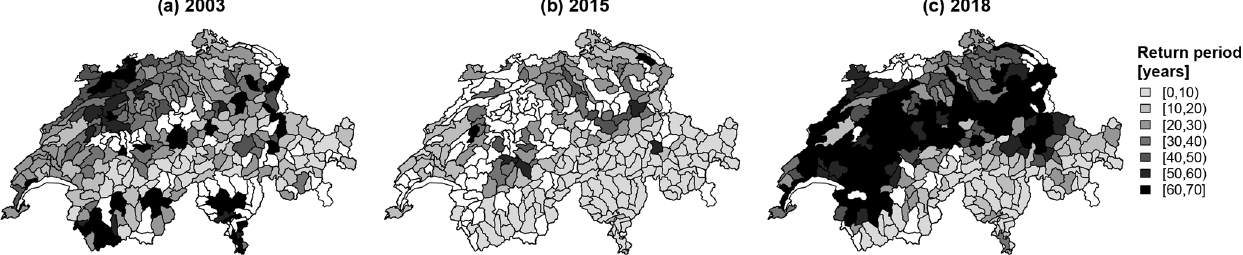
Figure 9. Estimated bivariate AND return periods in terms of discharge deficit and soil moisture deficits for the events in (a) 2003, (b) 2015, and (c) 2018 for the 307 catchments in the simulated dataset. For catchments displayed in white, no joint event for all variables was